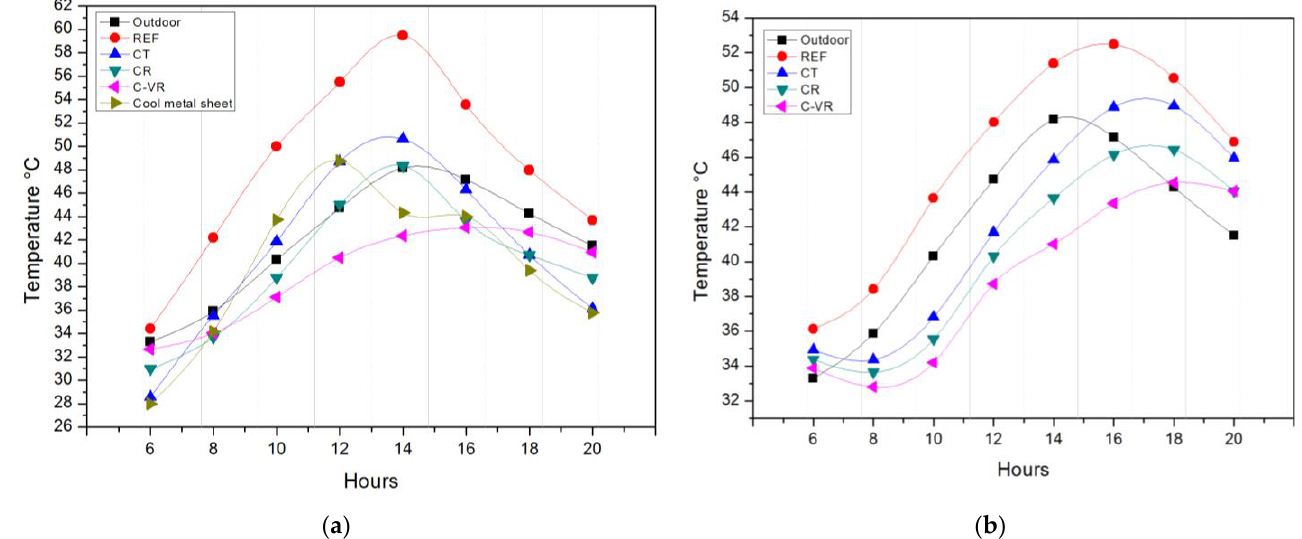
Figure 9. ( a ) Diurnal variations of the roof cells’ external surface temperatures . ( b ) Diurnal variations of the ceiling temperatures.